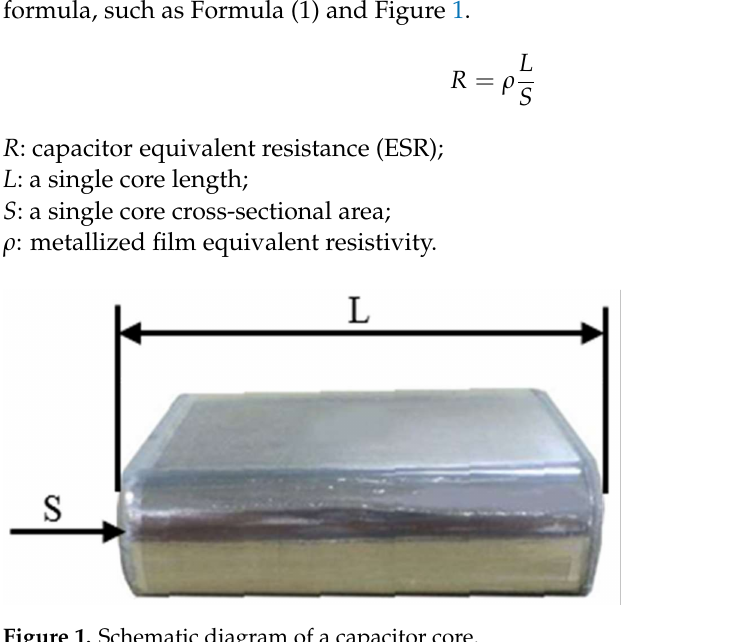
Figure 1. Schematic diagram of a capacitor core.